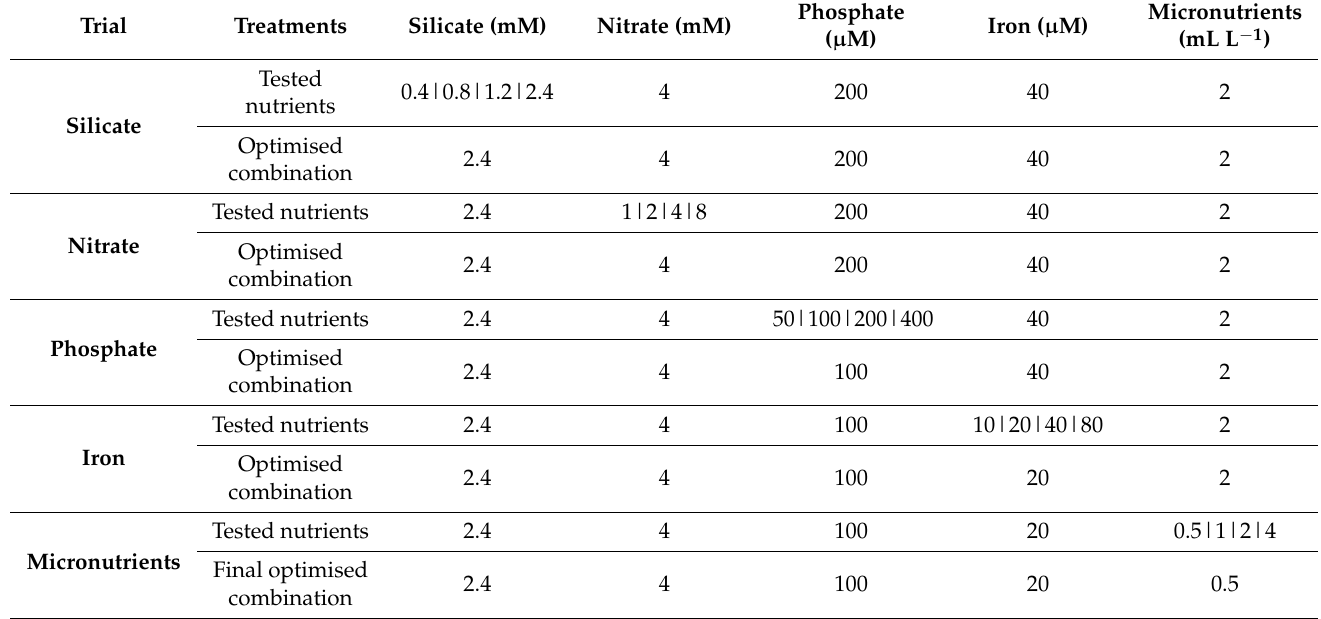
Table 2. Nutrient combinations as well the optimised concentrations that were obtained throughout the stepwise nutrient optimisation process of the S. costatum growth